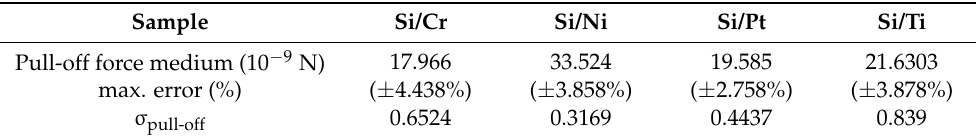
Table 3. Medium and dispersion value of pull off